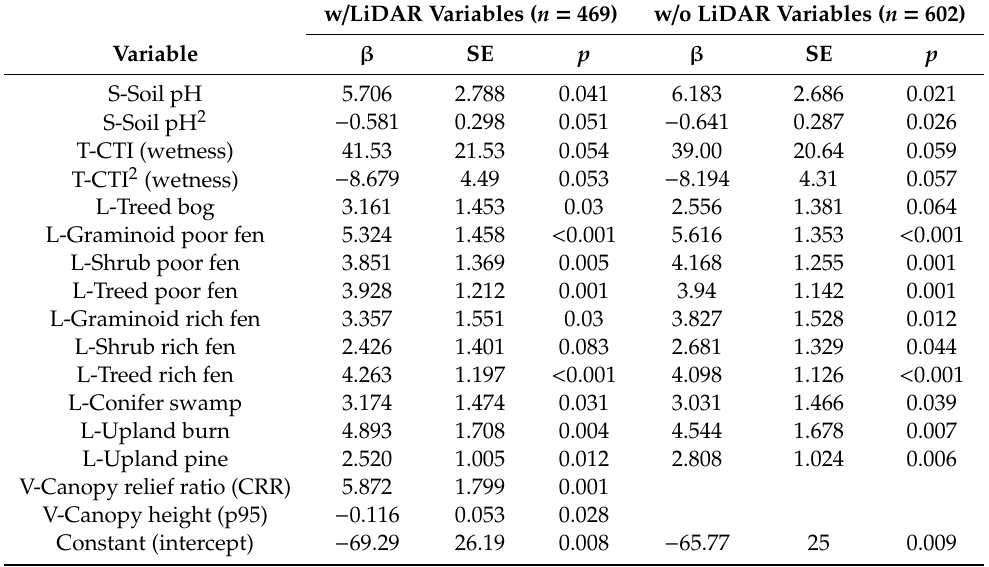
Table3. Logisticregressioncoefficients( β ),standarderrors(SE),andsignificance( P )ofthemost-supported (AIC) model (with and without LiDAR data) describing the probability of a S1 or S2 vascular plant being present within 0.25 ha plots in the Lower Athabasca region of Alberta, Canada. Land cover variables are in comparison to the reference category of deciduous